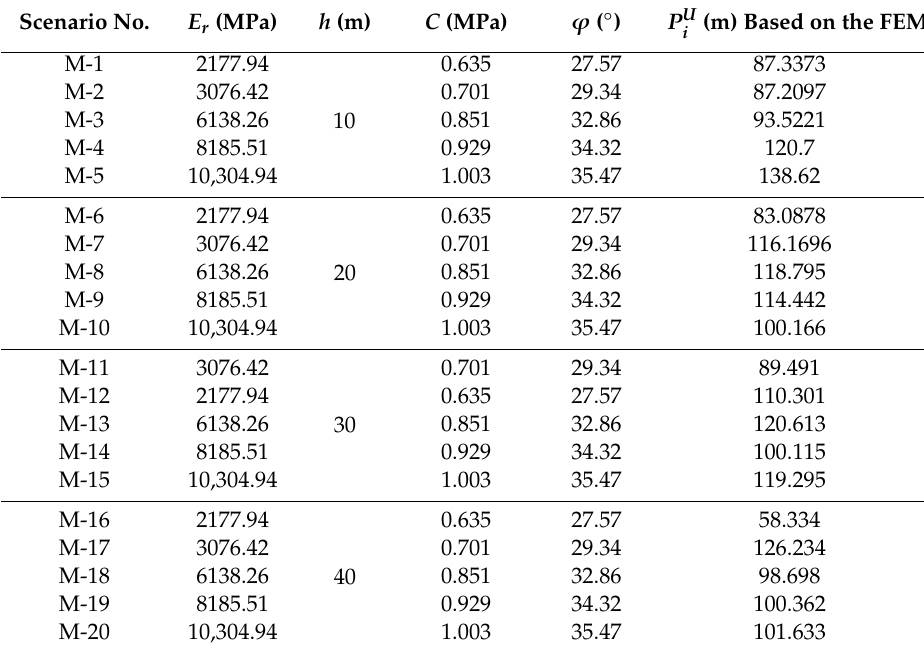
),underdifferentscenarios. FEM—finiteelementmodel. i